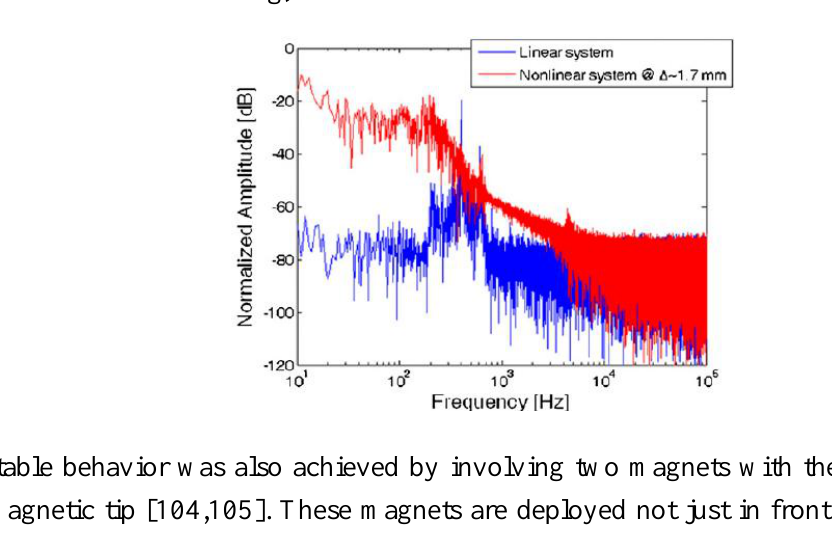
Figure 25. Displacement spectrum with σ = 20 μN [96] ( © IOP Publishing. Reproduced by permission of IOP